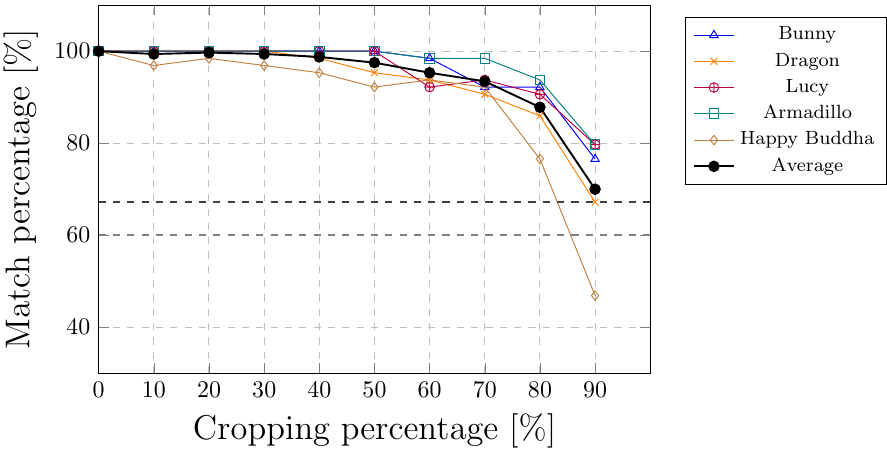
Figure 8. Cropping top attack. Table 5. Combined affine transformation and cropping attacks.